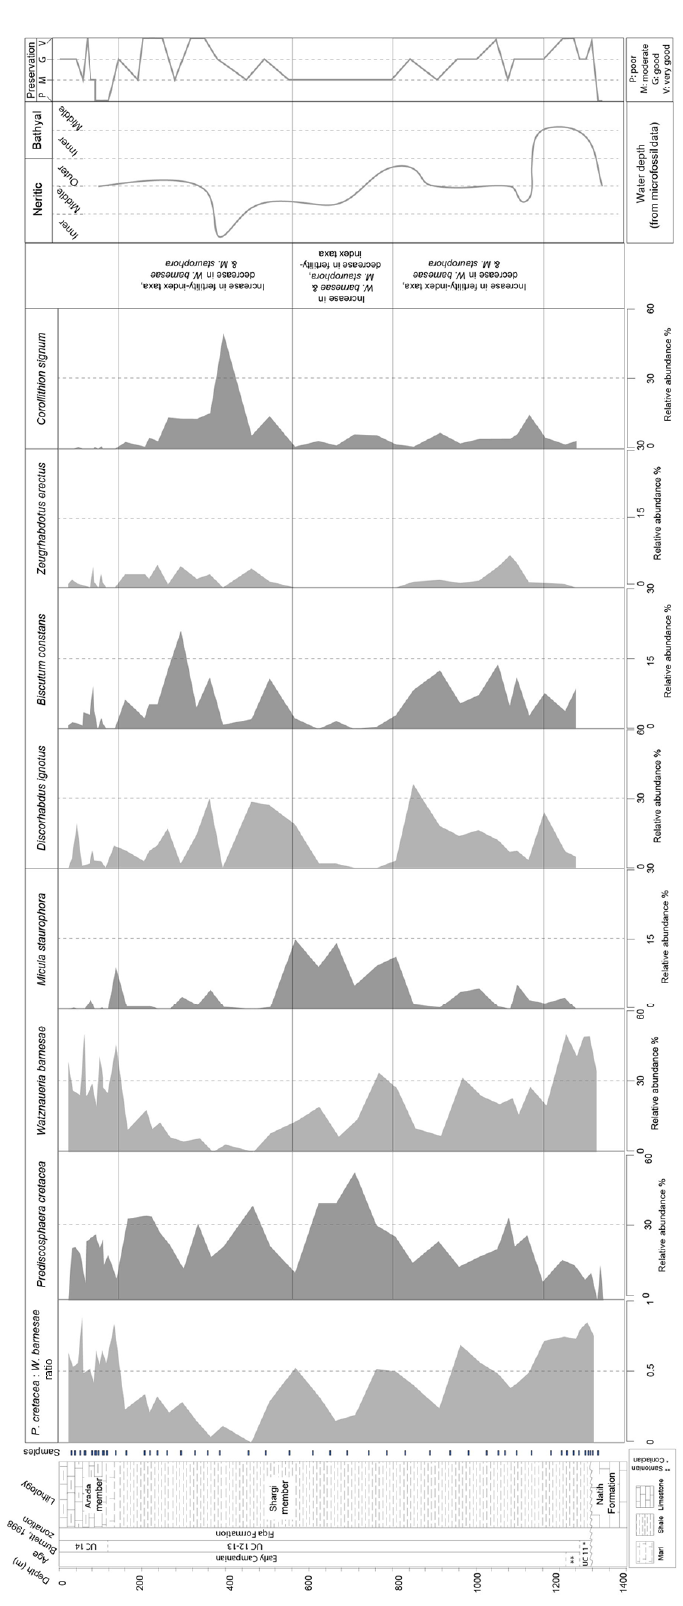
Figure 7. Changing abundance patterns of proxy marker taxa in the W-4, integrated with Ca% and palaeoenvironment.